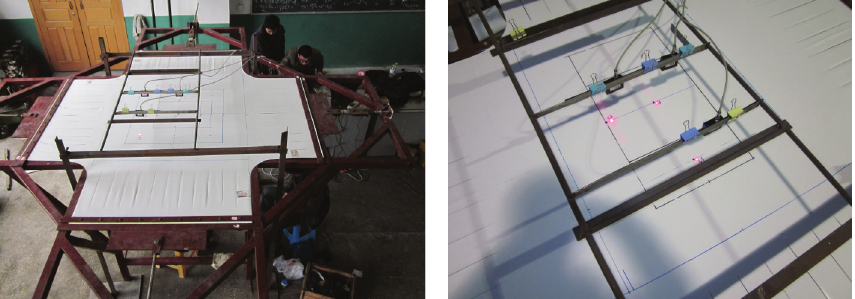
Figure 6: The field test situation.